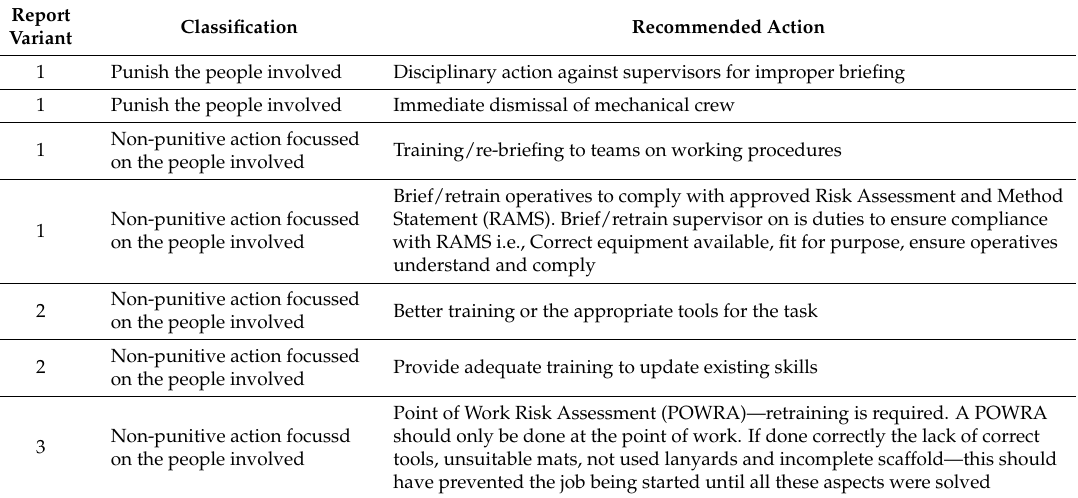
Table A1. Examples of human-focussed recommendations.